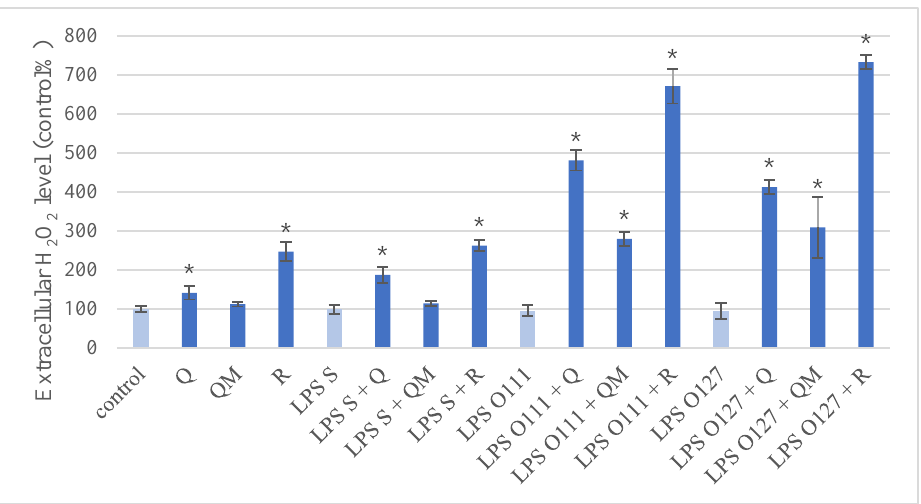
Figure 4. Extracellular hydrogen peroxide (H 2 O 2 ) level in porcine intestinal epithelial cells (IPEC-J2) after treatment with different types of lipopolysaccharides (LPS) from Salmonella Typhimurium (LPS S), E. coli O55:B5 (LPS O55), E. coli O111:B4 (LPS O111), and E. coli O127:B8 (LPS O127) in 10 µg/mL concentration; quercetin (Q), 3-o-methylquercetin (QM) and rhamnazin (R) in 50 µM concentration; and their combinations. Data are shown as means with standard deviations ( n = 6/group; * p < 0.05) in control percentage and are statistically compared to those of the control group.